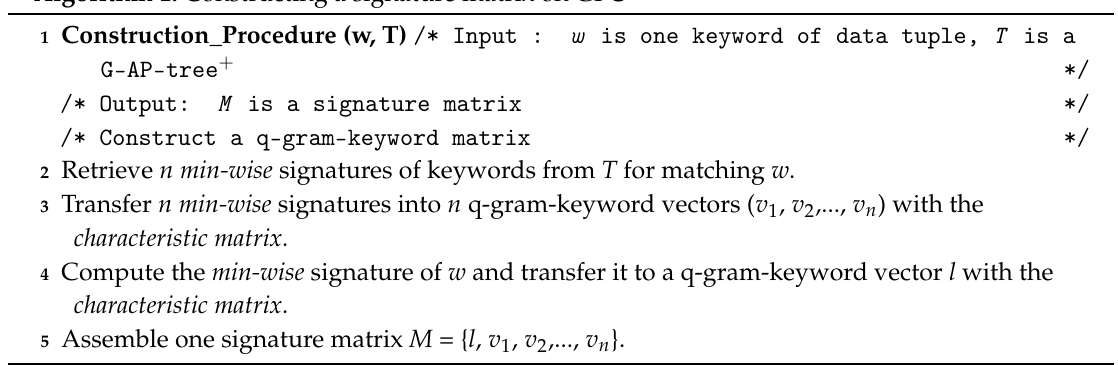
Algorithm 1: Constructing a signature matrix on GPU